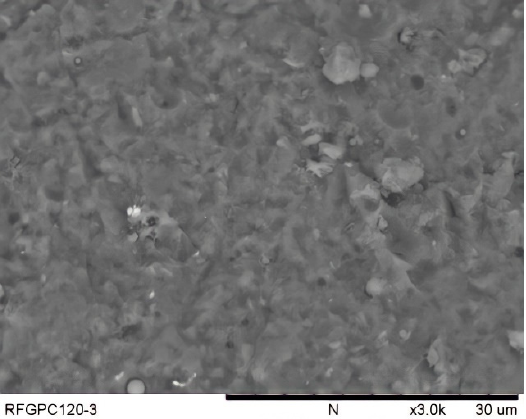
Figure 13. SEM image of fractured GPC pieces from adjacent parts of steel illustrating dense struc- ture.